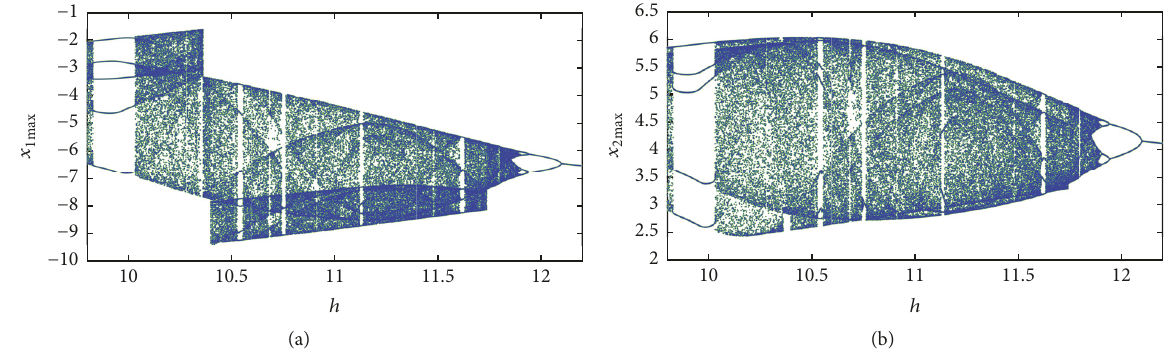
Figure 3: Bifurcation of the HPS (9) with the parameter ℎ ((a) 𝑥 1 and (b) 𝑥 2 ).